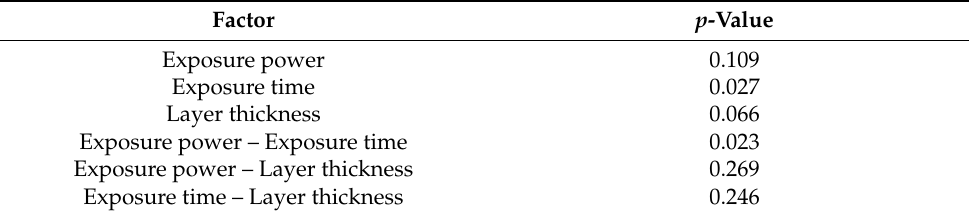
Table 5. p -values of analysed factors and their